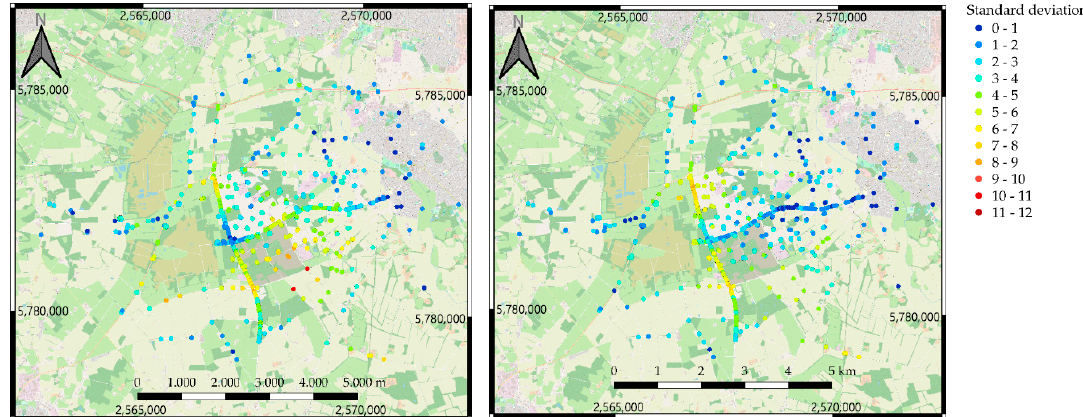
Figure 8. Standard deviations of di ff erences between InSAR results and levelling. Left-hand side from geometric orbit combination, right-hand side Multi-Mogi approach.